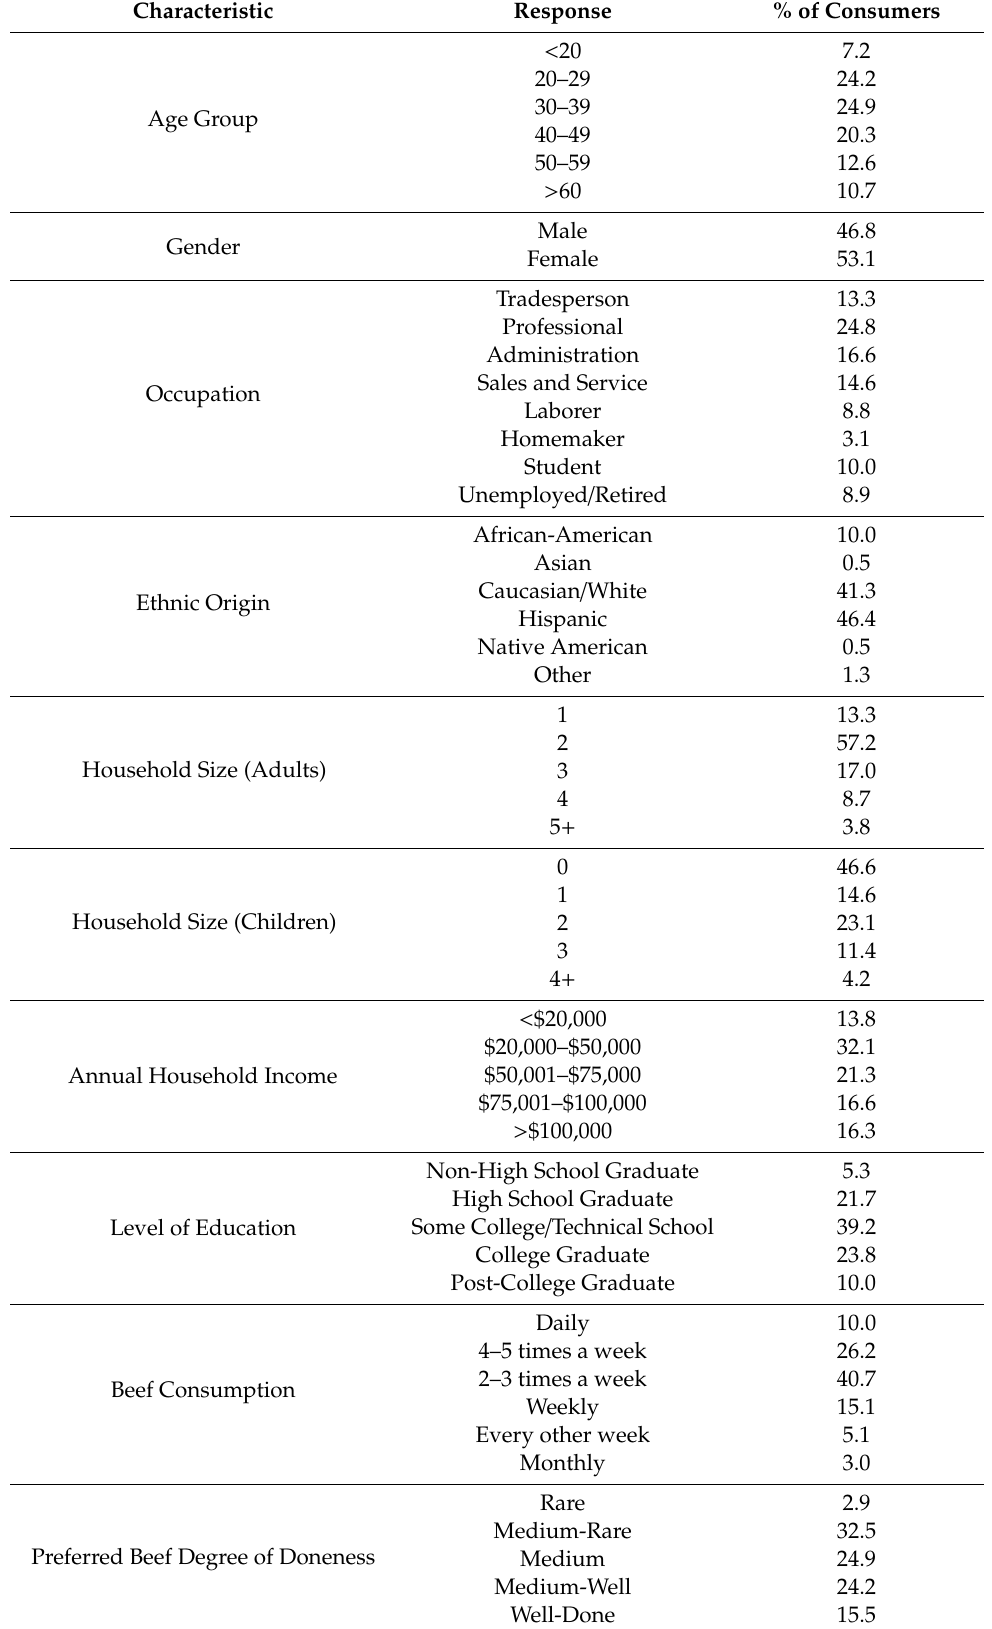
Table 2. Demographic characteristics of consumers ( n = 1080) who participated in consumer sensory panels at Texas Tech University in Lubbock,